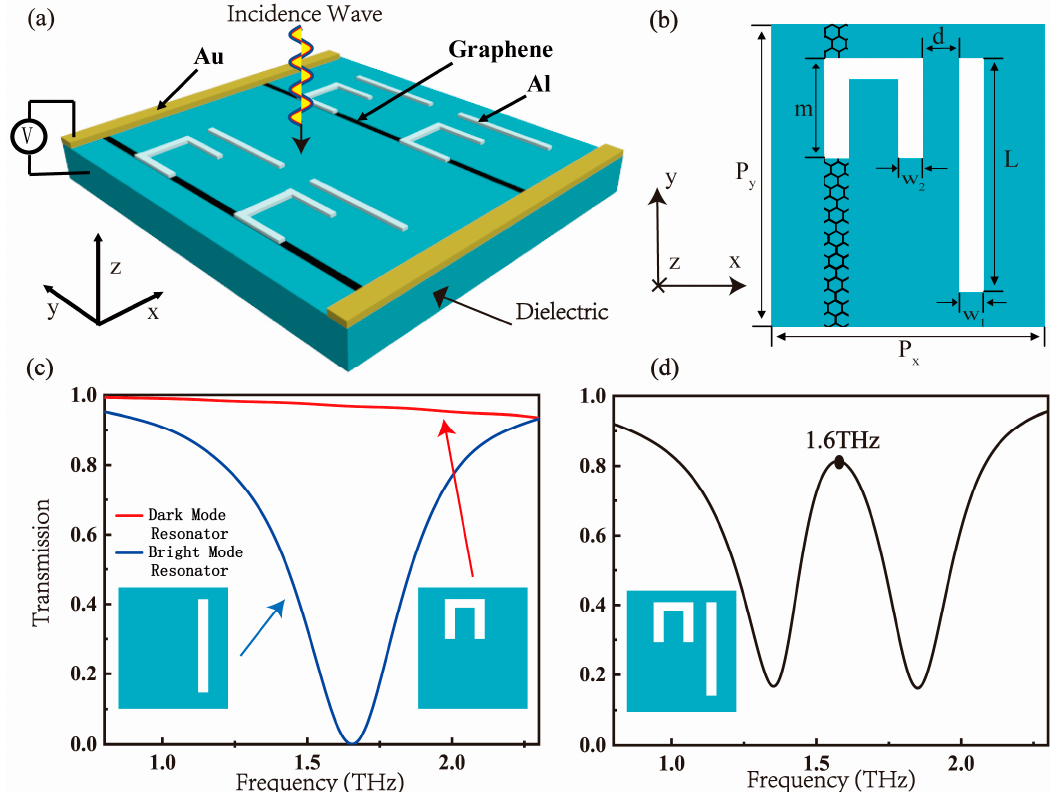
Figure 1. ( a ) The schematic representation of a metamaterial device under a plane wave incident; ( b ) the geometric parameters of a single substructure of metamaterials: P x = 80 µm, P y = 120 µm, L = 80 µm, m = 28 µm, w 1 = 5 µm, w 2 = 4 µm, d = 3 µm perpendicularly. ( c ) shows the transmission spectrum of the bright and dark modes resonator, and ( d ) shows the transmission spectrum of the EIT analogue structure combined with the bright and dark modes resonator under the incident plane wave with polarization direction y.